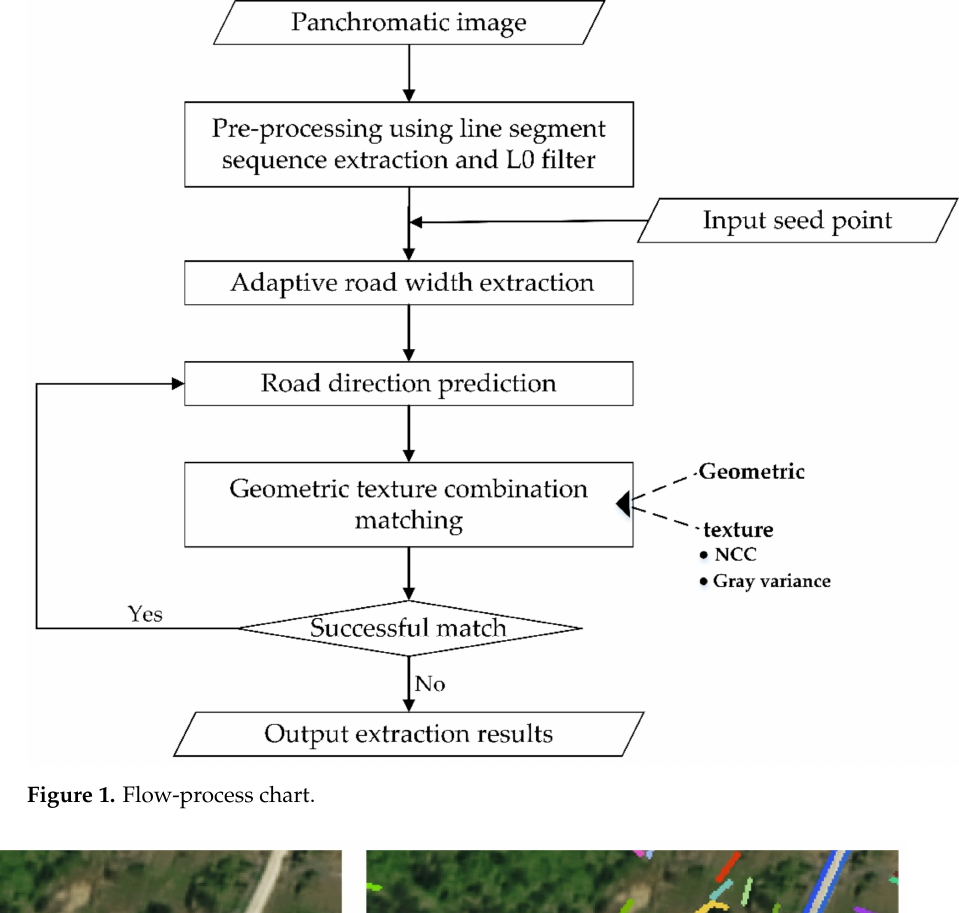
Figure 1. Flow-process chart.